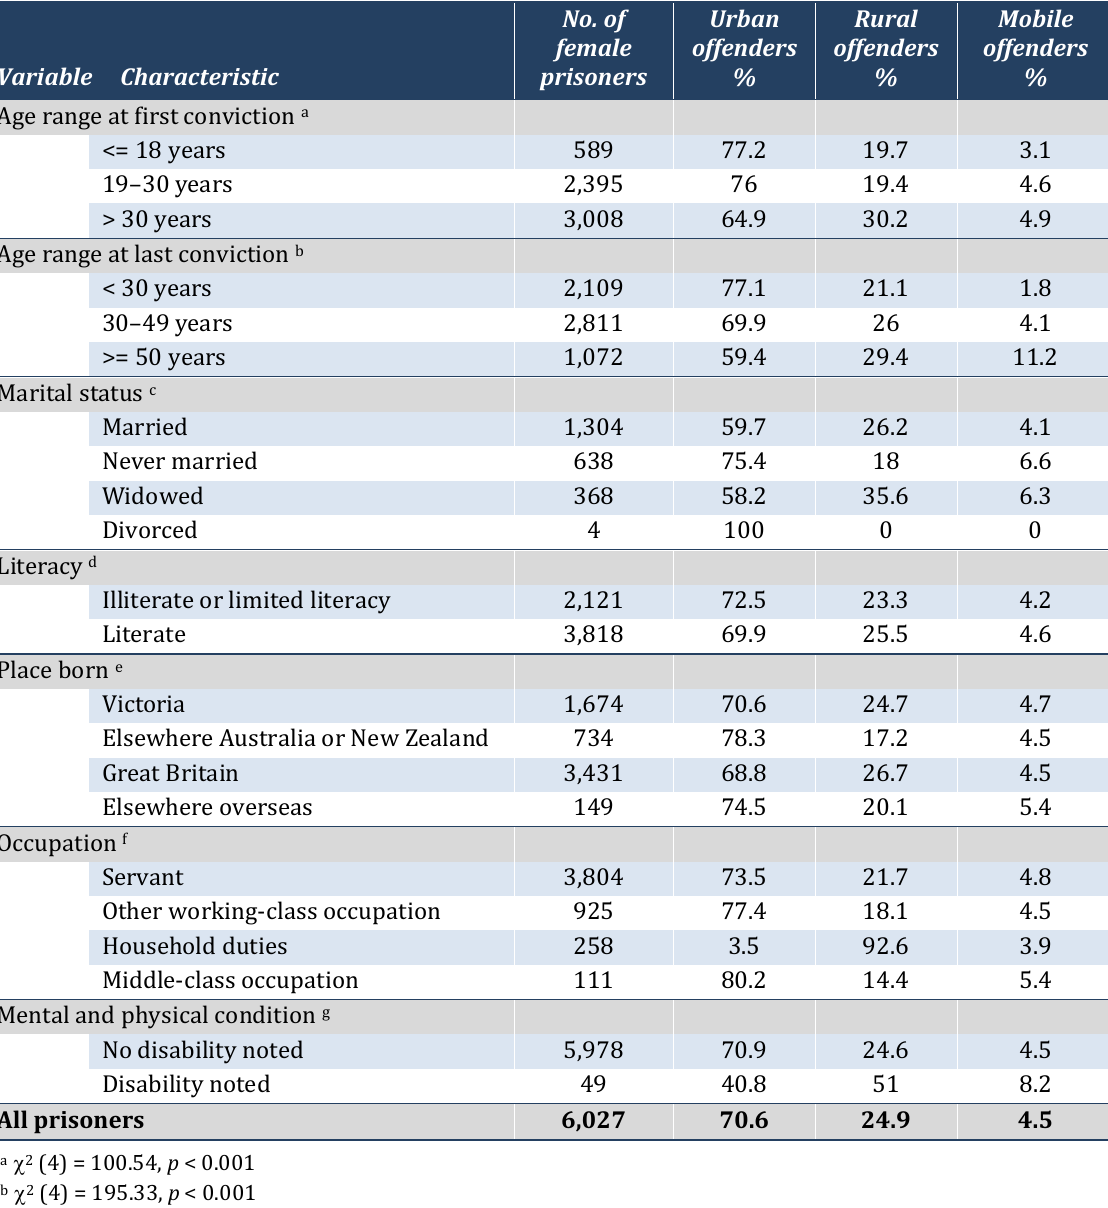
Table 4: Background characteristics of urban, rural and mobile offenders